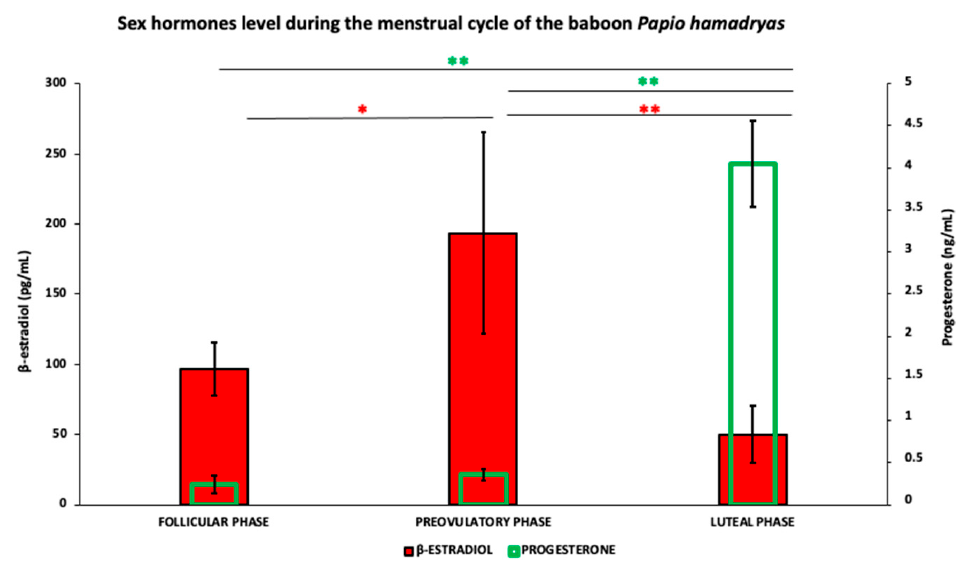
Figure 3. Serum concentration of beta-estradiol and progesterone in the baboon Papio hamadryas during the menstrual cycle. Values were expressed as means ± standard deviation (S.D.). * = p < 0.01; ** = p < 0.001.